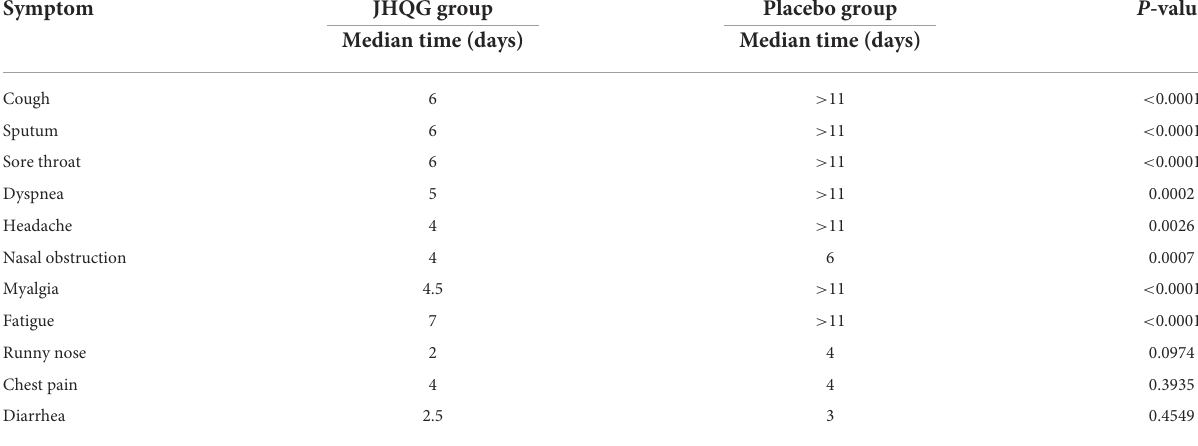
TABLE 9 Comparison of the recovery time for individual symptom in JHQG and Placebo group. Symptom JHQG